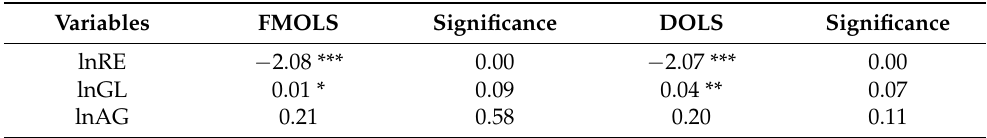
Table 8. FMOLS and DOLS tests (EF).